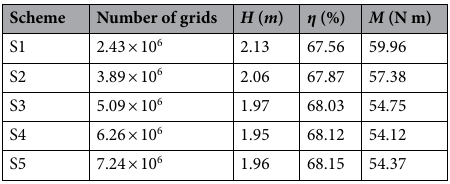
Table 4. Grid independence test.